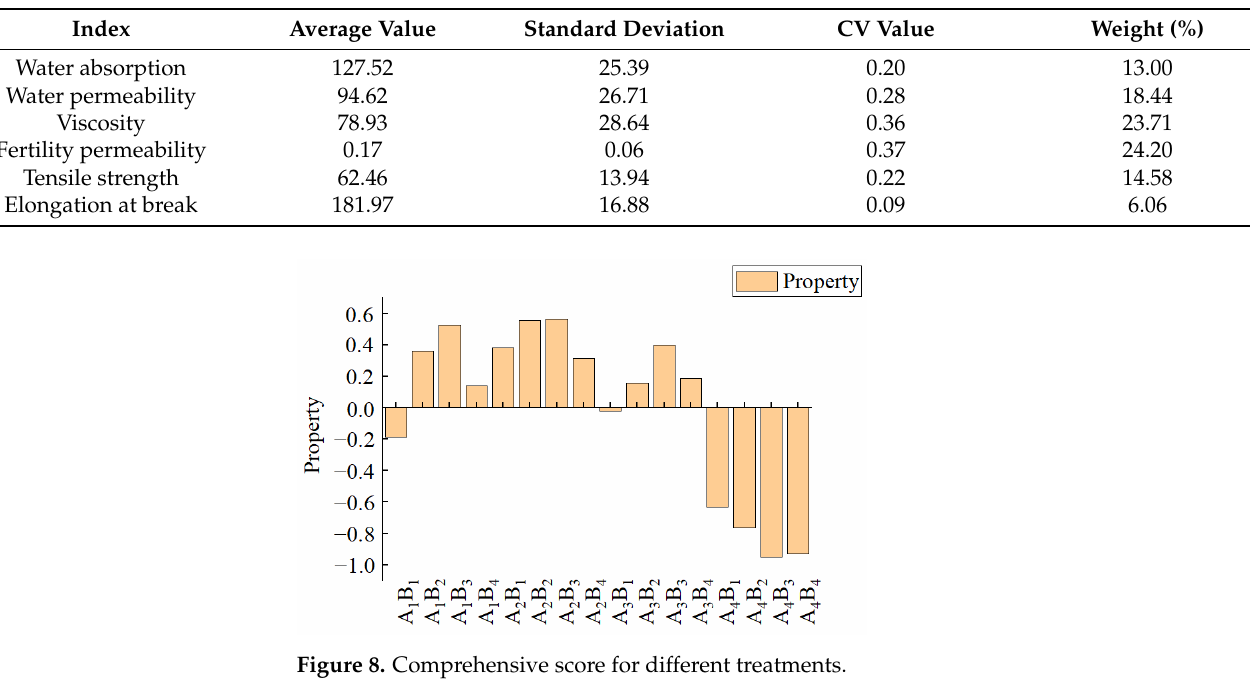
Table 1. Weight coefficient of different indices.